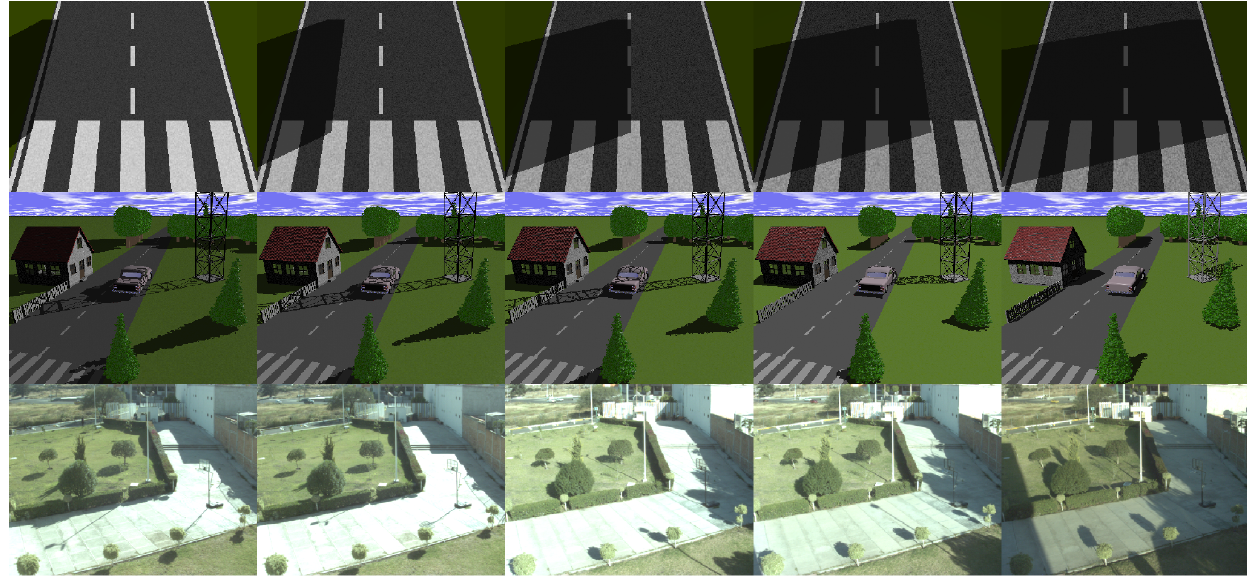
Figure 1. Data sets used for the evaluation of algorithms. The first and second rows are synthetic and the third row is a real scenario. The images illustrate changes in the illumination due to the relative movement of the